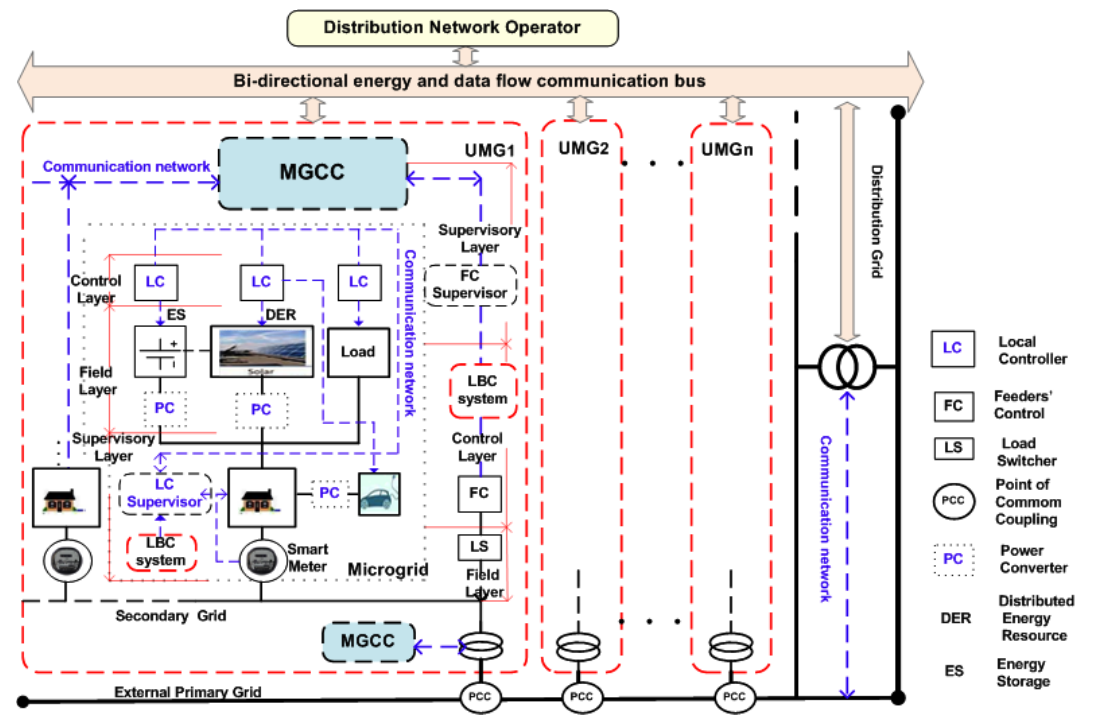
Figure 1. General Architecture of Urban